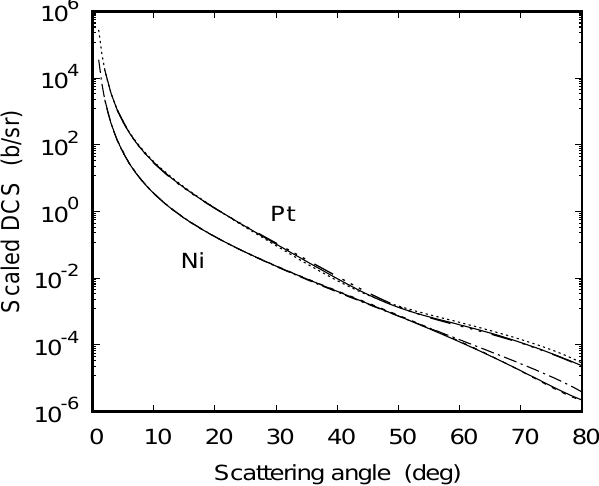
Figure 19. Differential cross section for 140 MeV electron impact (——-) on Ni 58 (lower line) and Pt 196 (upper line) as function of the scattering angle θ . Included are the results at 70 MeV impact for Ni 58 ( − · − · − ) and Pt 196 ( · · · · · · ) (scaled to 140 MeV) as well as the scaled results at 280 MeV impact for Ni 58 ( − − −− ) and Pt 196 ( − · · · − · · · − ) according to (15), with E